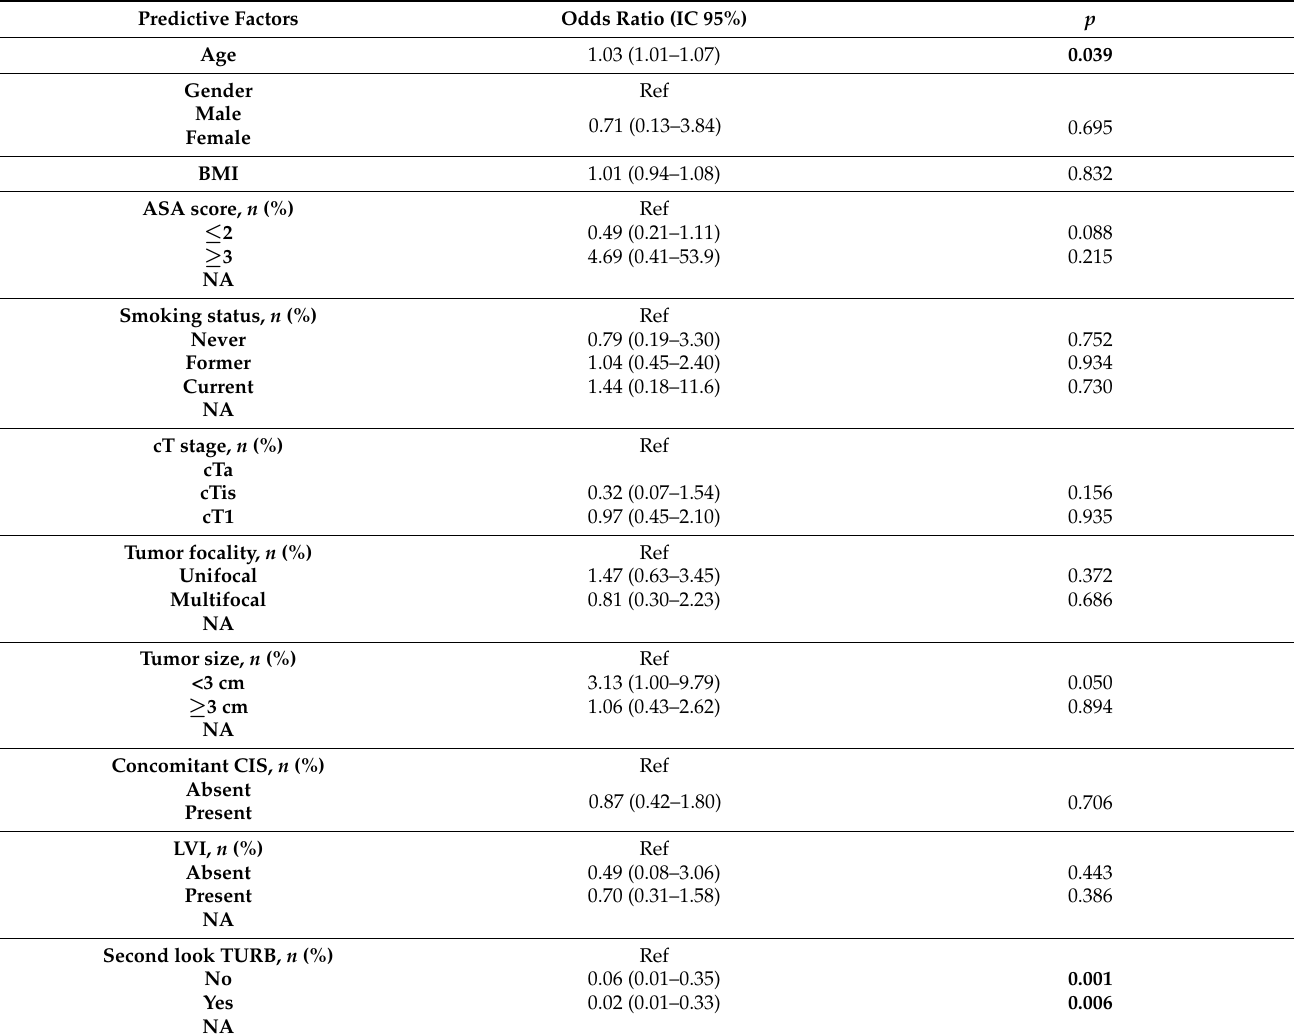
Table 7. Propensity score model that predicted the receipt of upfront vs. delayed eRC in included patients with HR-NMIBC. Bold: It is a significant